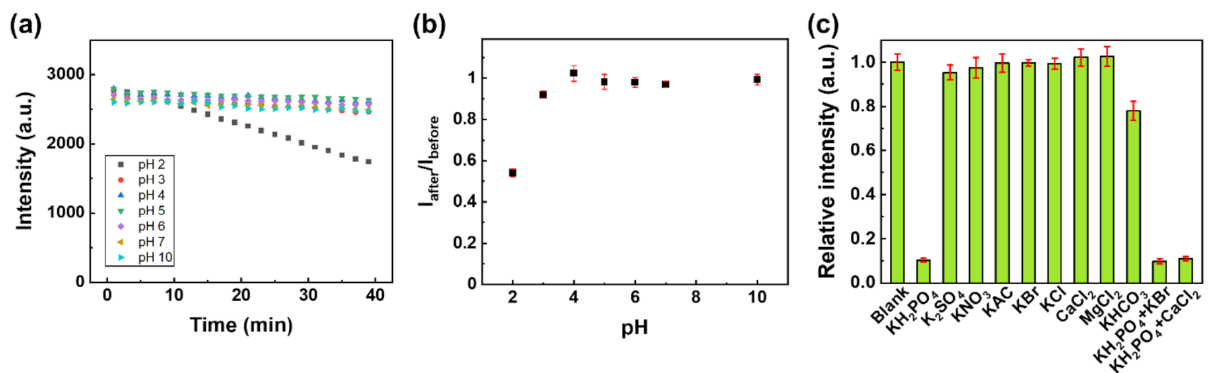
Figure 7. ( a ) The luminescence intensity of Eu-TCA/GMF as a function of time under various pH conditions. ( b ) I after / I before of Eu-TCA/GMF ( n = 6) as a function of pH, where I before is